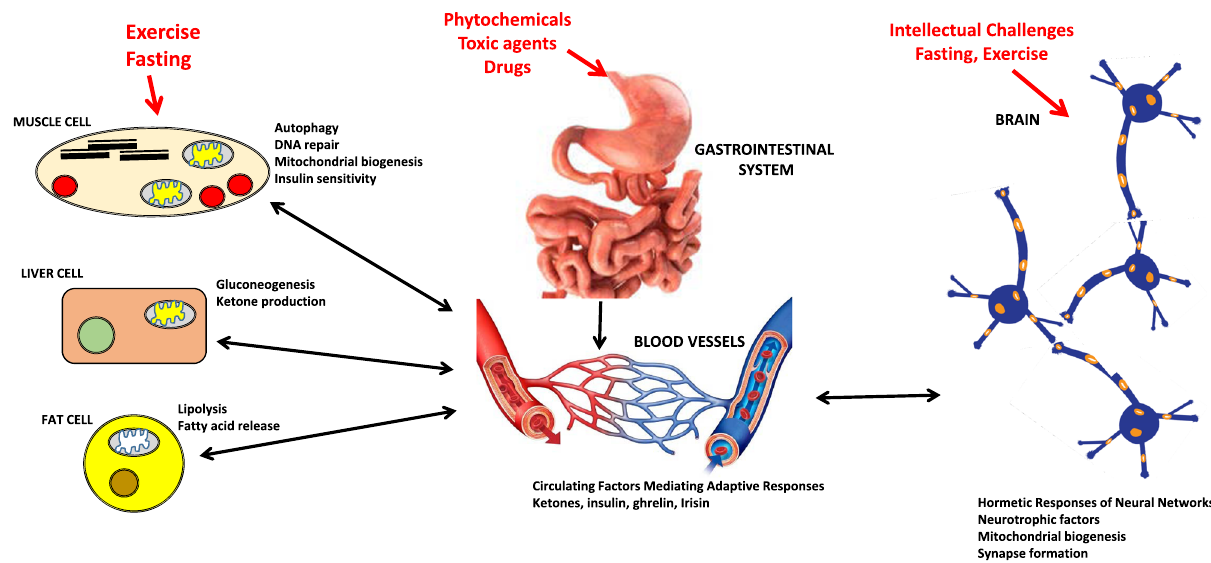
Fig. 2 Responses to hormetic challenges are coordinated across multiple organ systems, and involve both cell autonomous molecular mechanisms, and signals transmitted between different tissues. Exercise and fasting impose bioenergetic challenges to multiple organ systems, with responses of muscle, nerve cell networks, liver, and adipose cells being particularly important during the exercise. A major source of exposures to potentially toxic agents is their ingestion as components of food and water, or as man-made drugs. Numerous signaling molecules are released into the blood in response to environmental challenges, and function to coordinate hormetic responses of various organ systems. The brain plays major roles in adaptive responses to a wide range of hormetic exposures, mediating both immediate responses, and enduring changes in synaptic connectivity, and learning and memory, that optimize performance under challenging environmental conditions. (for in-depth discussion see refs. 36, 41, 77). Images for Digestive Tract and Capillaries from Wikimedia